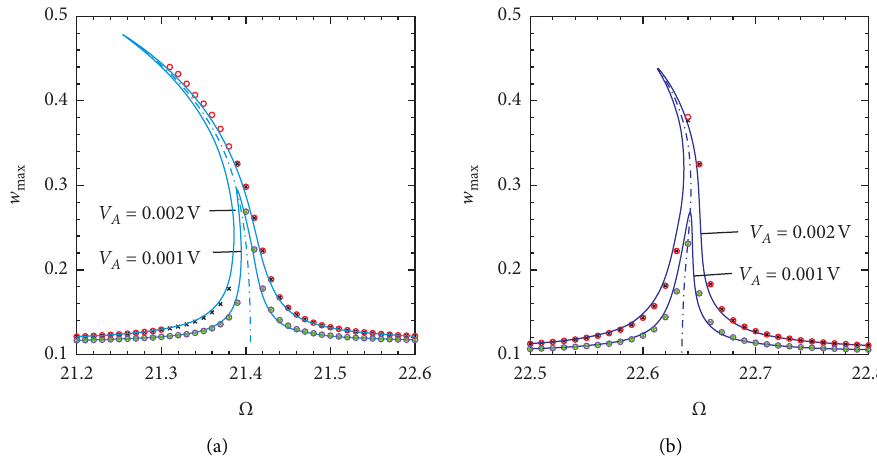
Figure 11: Amplitude-frequency curve: V